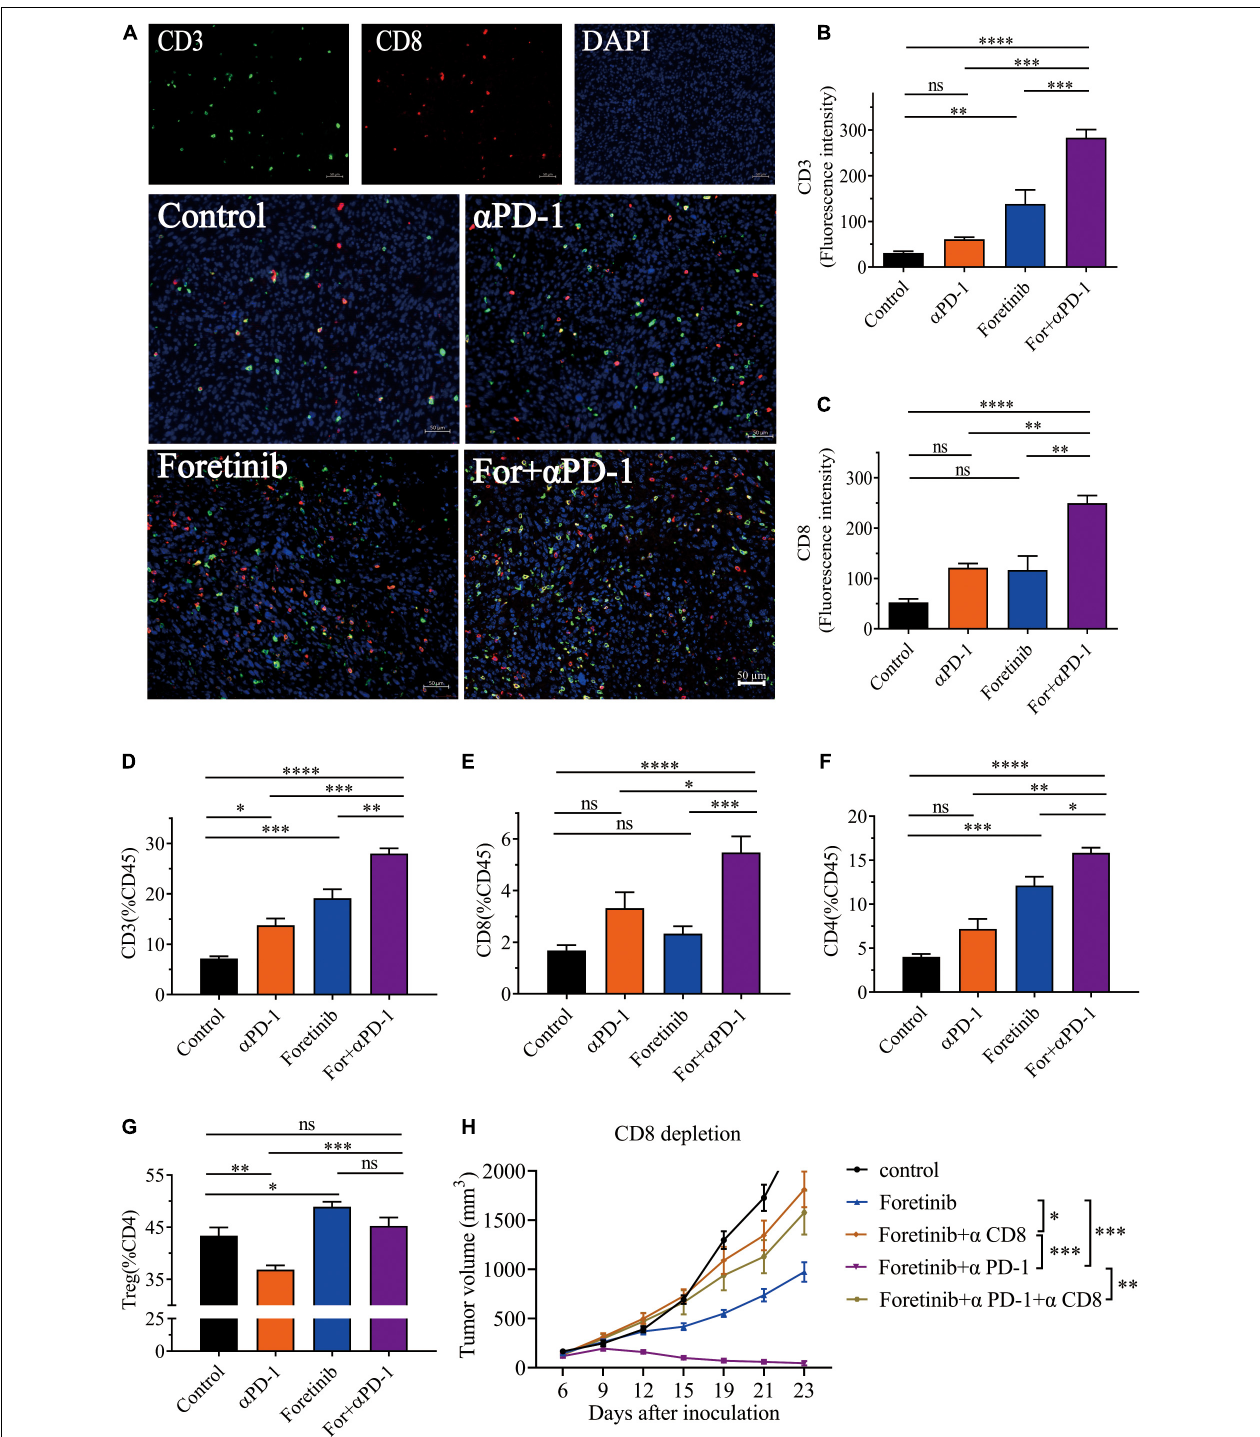
FIGURE 3 | Combination therapy enhanced T cell infiltration and induces CD8 + T cell-dependent anti-tumor immune response. After the treatment was completed, T cell infiltration in MC38 tumor tissue was detected by immunohistochemistry. Representative immunofluorescent images of CD3, CD8, DAPI nuclear staining and the merge picture from each group (A) , and the fluorescence intensity of CD3 (B) and CD8 (C) were quantified in the tumor tissues. Scale bar, 50 µ m ( n = 5 mice per group). (D–F) Percentages of CD3 + T cells, CD8 + T cells and CD4 + T cells in tumor. (G) The percentages of Tregs (CD25 + FoxP3 + ), gated on CD4 + T cells. (H) Tumor growth of CD8 + T cell depletion assay ( n = 6 mice per group). The data is presented using the mean ± SEM where applicable, * ( P ≤ 0.05), ** ( P ≤ 0.01), *** ( P < 0.001), **** ( P < 0.0001), and ns (no statistical significance, P ≥ 0.05).